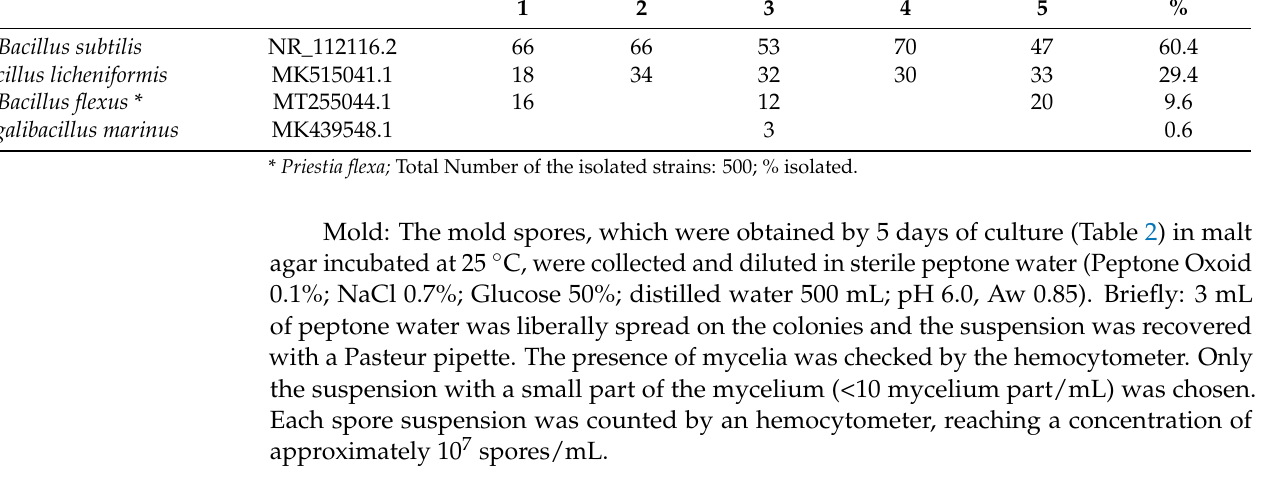
Table 2. Fungal species isolated from